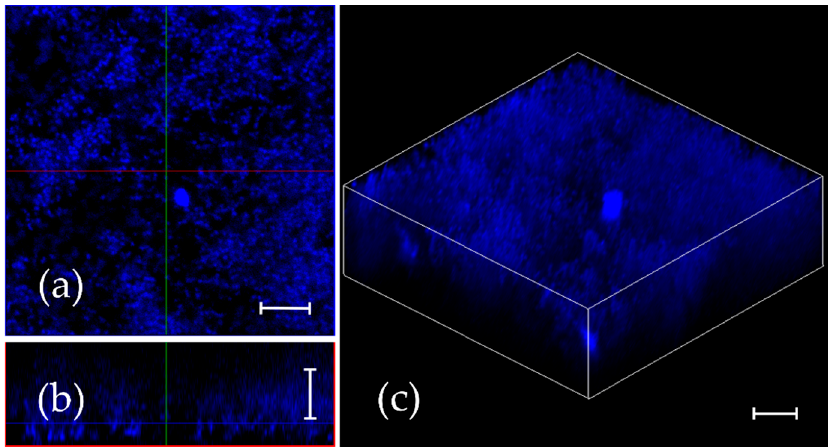
Figure 4. F145 diffusion into the mature S. aureus biofilm. The 24 h old biofilm was treated with F145 for 1 h and analyzed with confocal laser scanning microscopy using a single-channel mode. ( a ) X; Y orientation of the biofilm; ( b ) Z-stack of the biofilm; ( c ) 3D-model of the biofilm. The scale bars indicate 10 μ m.